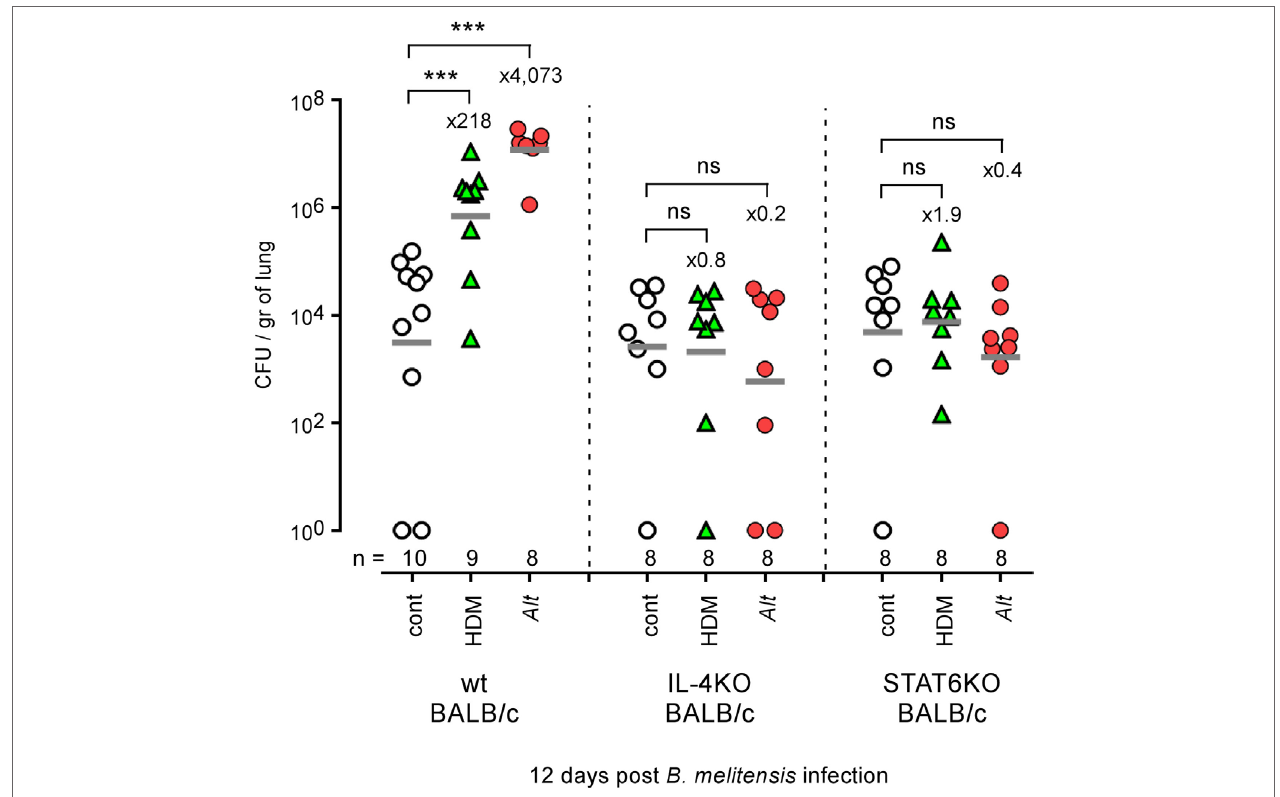
FigUre 5 | Impact of IL-4 and STAT6 deficiency on asthma-induced Brucella susceptibility in BALB/c mice. Wild-type, IL4 − / − and STAT6 − / − BALB/c mice received repeated i.n. administration of phosphate-buffered saline, HDM, or Alt before i.n. infection with 2 × 10 4 CFU of mCherry- Brucella melitensis . The mice were sacrificed at 12 days post infection. The data represent the number of CFU/gr of lung at 12 days post infection from each group. n denotes the number of mice used for each lineage. These results are representative of at least two independent experiments. *** p <